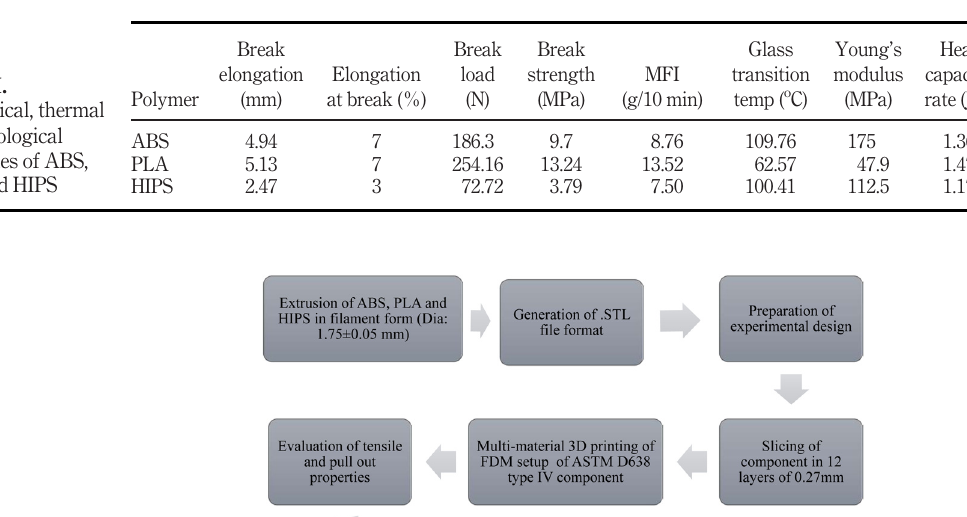
Figure 1. Steps involved in multi-material 3D printing